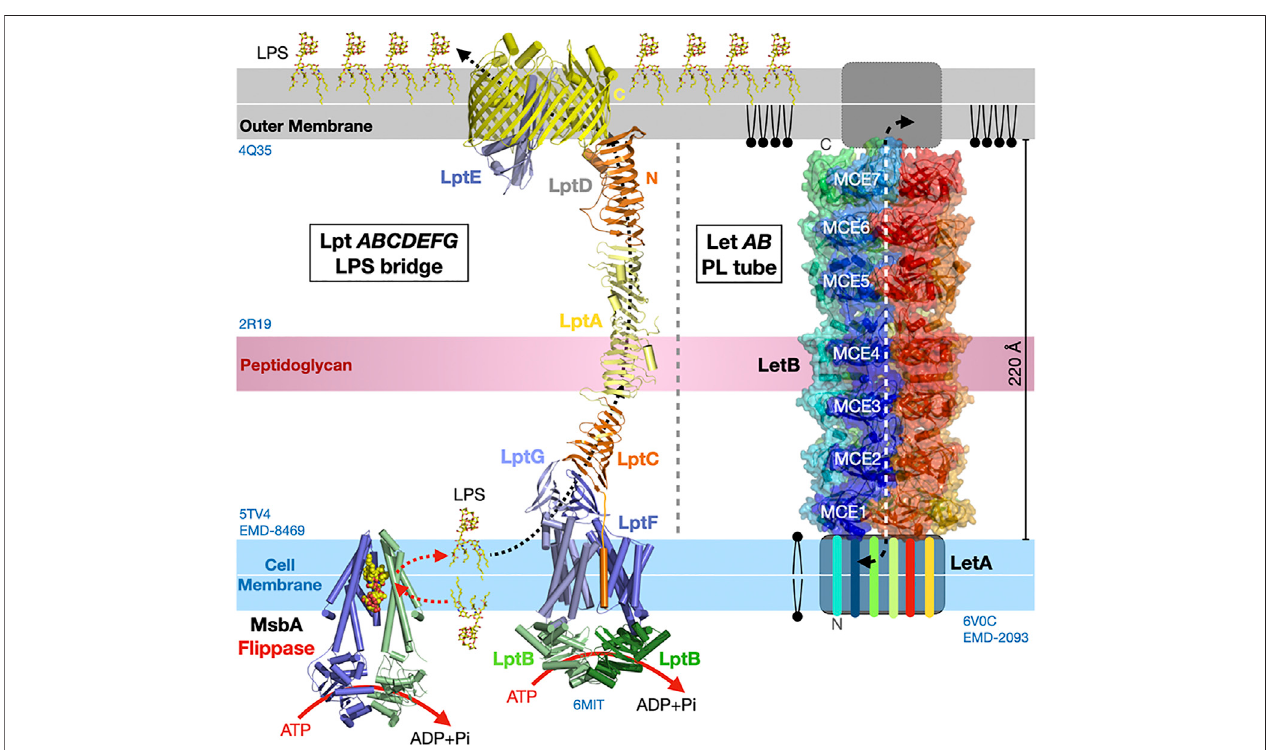
FIGURE 10 | Bulk lipid transfer systems in Gram-negative bacteria. Structure of the Lpt bridge transferring LPS (PDB 5TV4 2R19 4Q35 6MIT EMD-8469) and the LetBproteinaceousnanotube transferringPLsbetweenmembranesinGram-negativebacteria (PDB6V0C EMD-20993). The β -jellyrollsdomainspresentinLptC,F, G, A and D align to form a periplasmic bridge with a solvent-exposed V-shaped hydrophobic groove. Hexamers of LetB form a protein tubular structure with a central channelcapableofbindingPLsandspanningtheperiplasmicspace.ThesixLetBchainsarecoloredinarainbowpattern.ThesevenMCEdomainsrepeatedalong one chain (in blue) are labeled. The sides of the protein tube are porous enabling solvent to enter the channel. It is unclear what drives PL transfer in the Let system. Structures and membranes are drawn to scale.